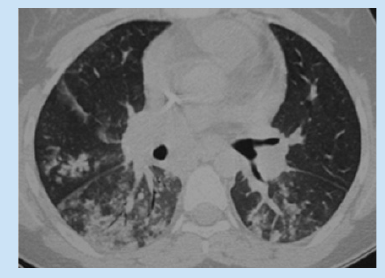
Fig. 24. Drug toxicity.